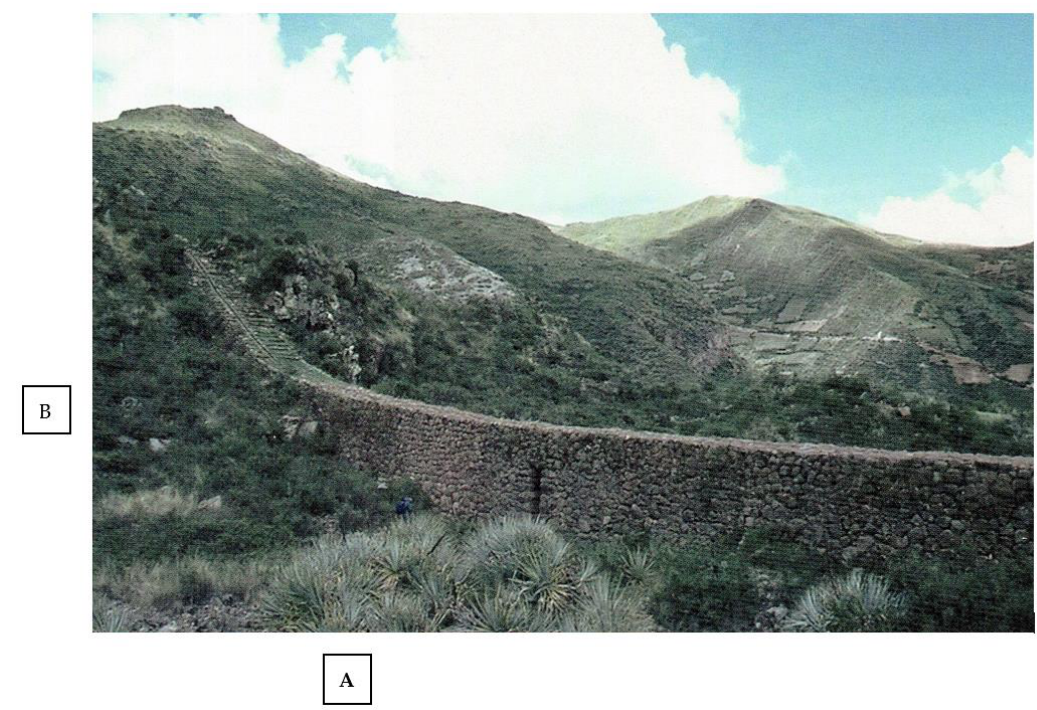
Figure 17. Alternate view of the Main Aqueduct Section 4 canal steep slope section shown in Figure 17. The hydraulic jump location occurs where the channel slope angle changes from steep to near horizontal shown on left side of figure. The hydraulic jump location on the aqueduct is located at the junction at the A and B coordinates. (Photo by C. Ortloff).